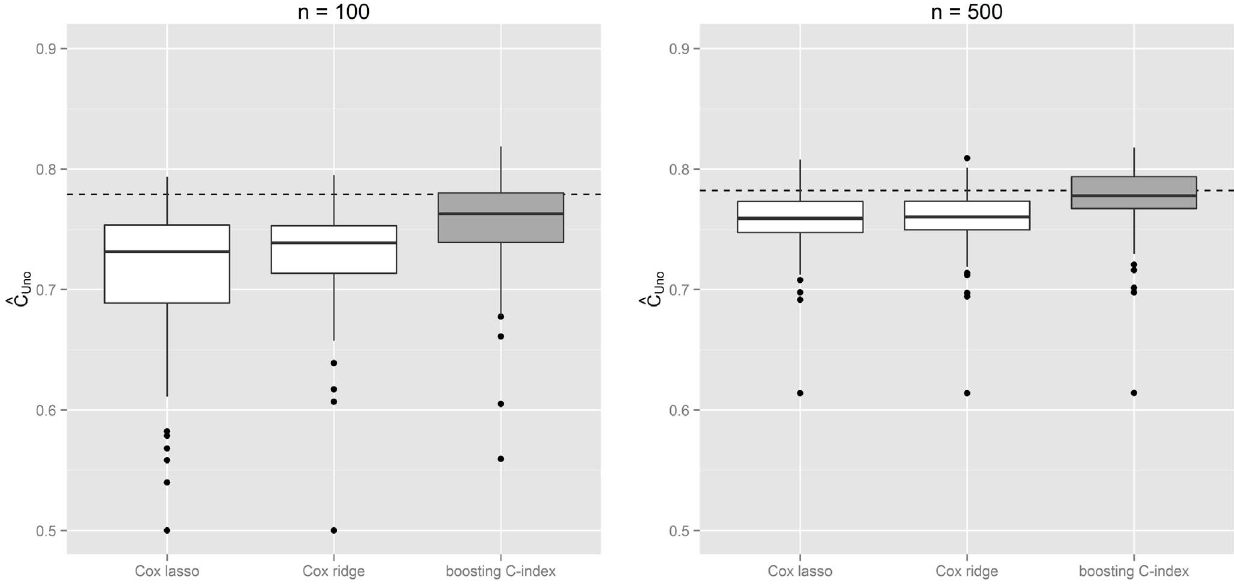
Figure 2. Simulation results for the discriminatory power obtained via the proposed C -index boosting approach and competing Cox-based estimation schemes. The marker combinations were optimized via the different approaches based on training samples of size n ~ 100 (left) and n ~ 500 (right). Boxplots represent the empirical distribution of the resulting ^ CC Uno on corresponding test samples. The dotted line corresponds to the discriminatory power resulting from the true combination of predictors with known coefficients.